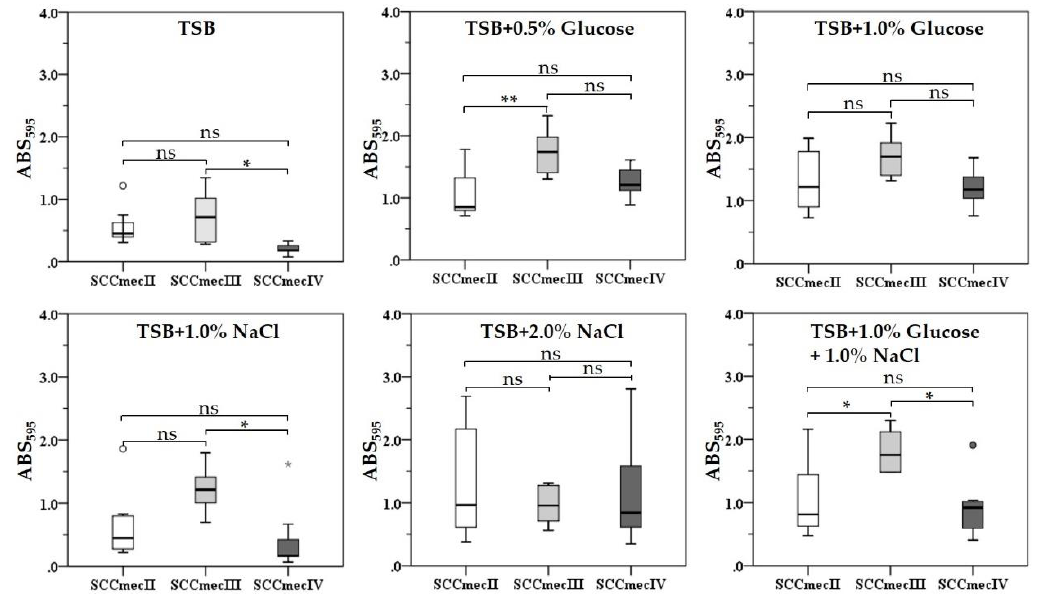
Figure 3. Biofilm formation by MRSA strains with distinct SCC mec types (SCC mec II, n = 8; SCC mec III, n = 6; and SCC mec IV, n = 7) grown in different culture media compositions. Box plot shows the median (horizontal thick blank line) of biofilms formed by MRSA strains. The lower and higher edges of the box represent the 25th and 75th percentiles, respectively. Box plot whiskers represent the 90th and 10th percentiles. P values were determined using Student′s t -test and asterisks indicate statistical significance (* = p ≤ 0.05, ** = p < 0.01). ( ns = p > 0.05, not statistically significant). Table 1. Phenotypic and genotypic characteristics of the S. aureus strains used in this study.